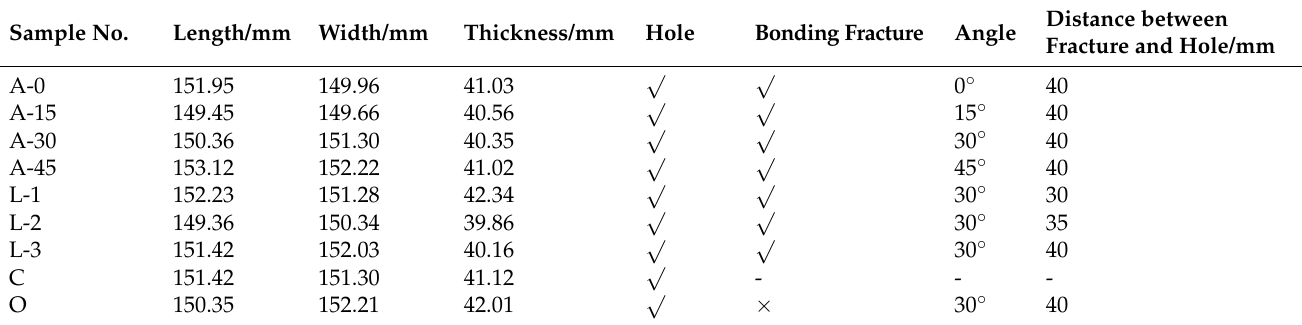
Table 2. Morphology and mechanical parameters of granite samples.